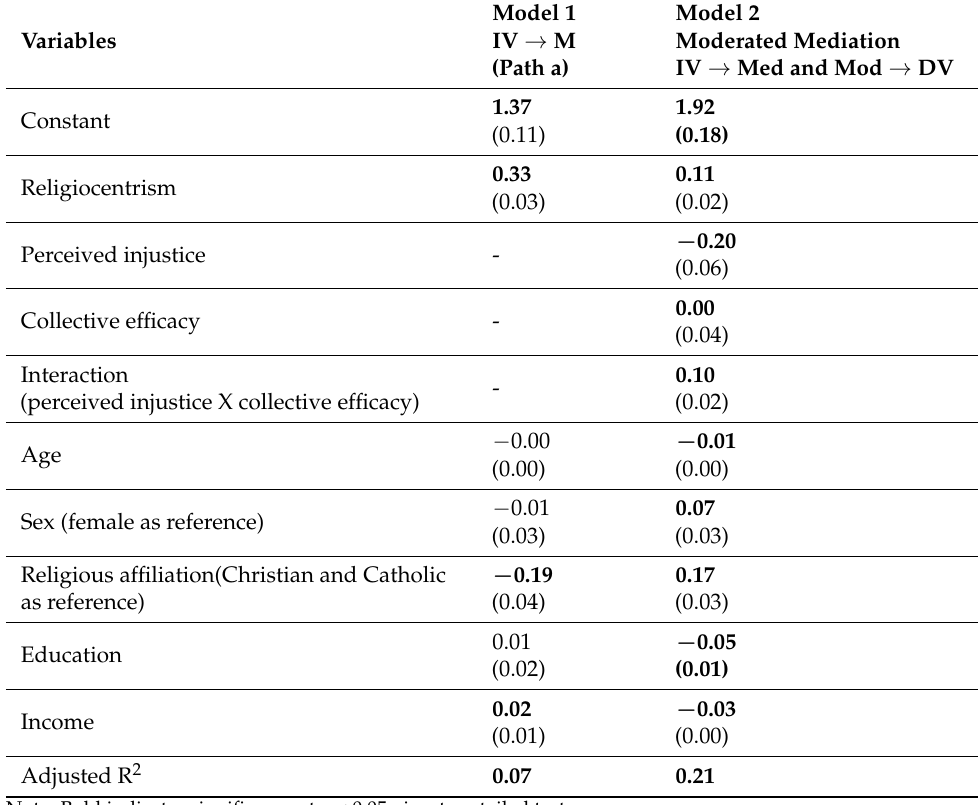
Table 2. Second-stage moderated mediation on religiocentrism and support for interreligious violence via perceived threat at the levels of collective efficacy (N = 2106, standard error in